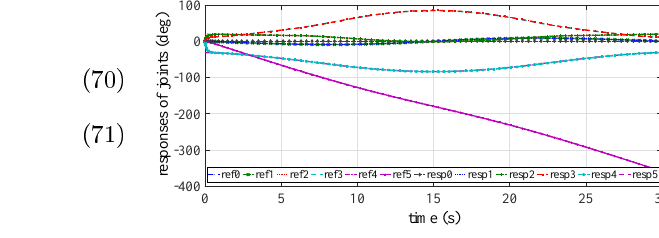
Fig. 9: Trajectory and response of six joints in the case of static pipe.